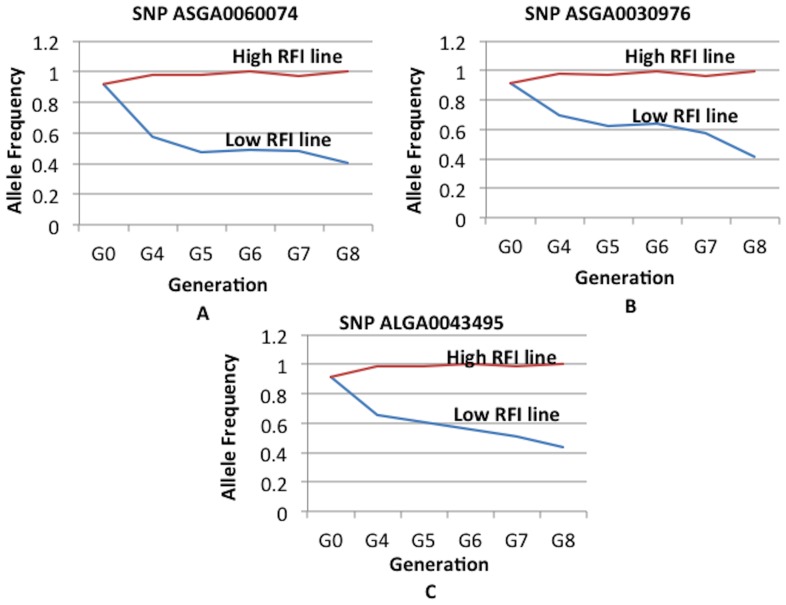
Allele frequency differences between the residual feed intake selection lines for the significant SNPs in each generation.Parts A, B and C show the allele frequency differences for the SNPs near to the KCNJ15 gene on SSC13 (ASGA0060074), near the ELOVL2 and TFAP2A gene on SSC7 (ASGA0030976), and near the GPX2 gene on SSC7 (ALGA0043495), respectively. KCNJ15: potassium inwardly rectifying channel, subfamily J, member 15; ELOVL2: elongation of very long chain fatty acids 2; TFAP2A: transcription factor AP-2 (activating enhancer binding protein 2)—alpha; GPX2: glutathione peroxidase 2. The X axes represent generations and Y-axes show allele frequencies.